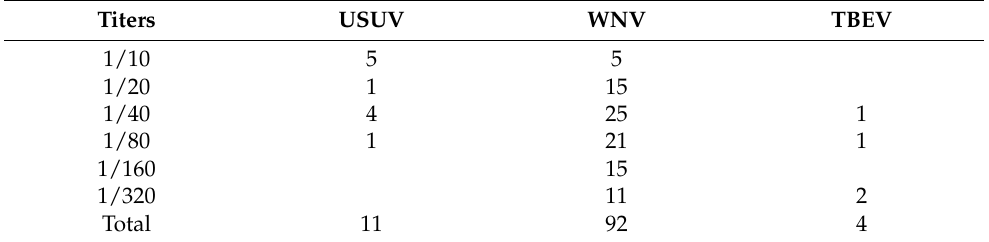
Table 2. Distribution of MNT titers in samples from horses infected by USUV, WNV, and